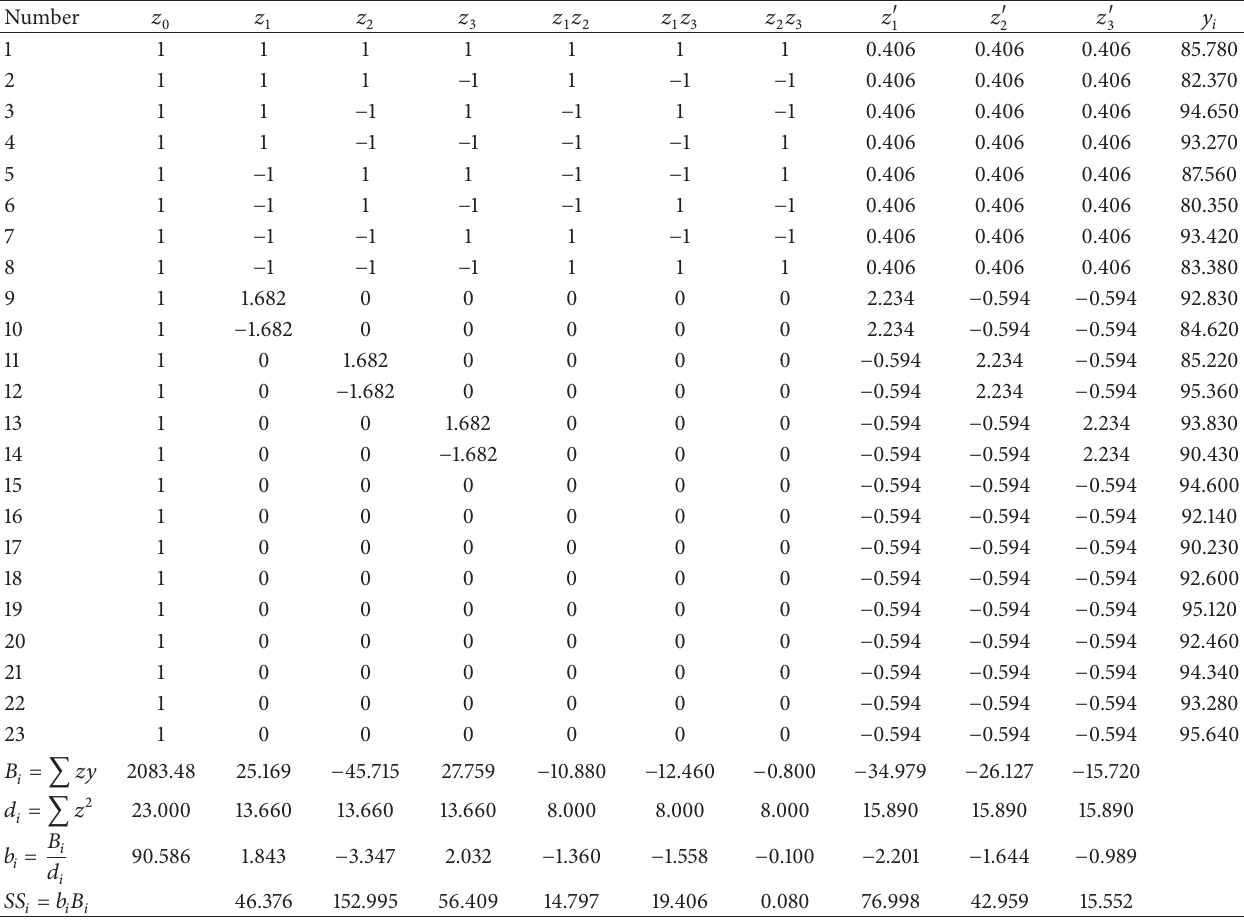
Table 3: Orthogonal rotation design structure matrix and calculation.